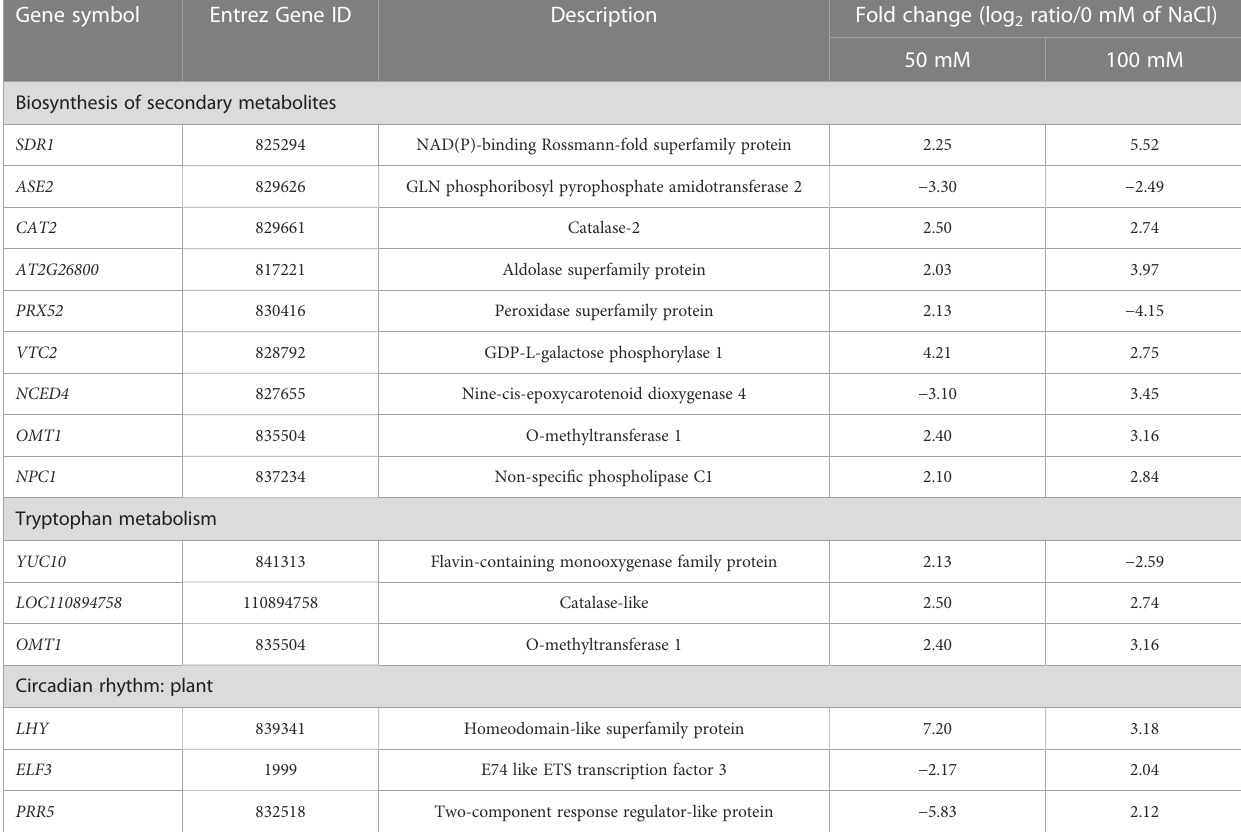
TABLE 4 Differential expression of genes related to the KEGG pathway in the NaCl concentrations. Gene symbol Entrez Gene